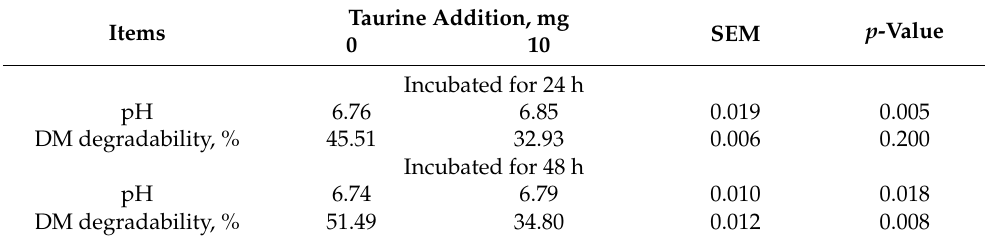
Table 4. Effects of taurine on in vitro rumen pH and DM degradability (Trial